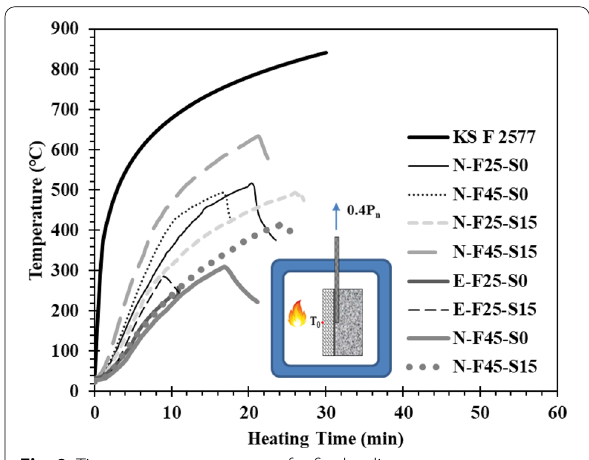
Fig. 9 Time–temperature curves for fire loading.